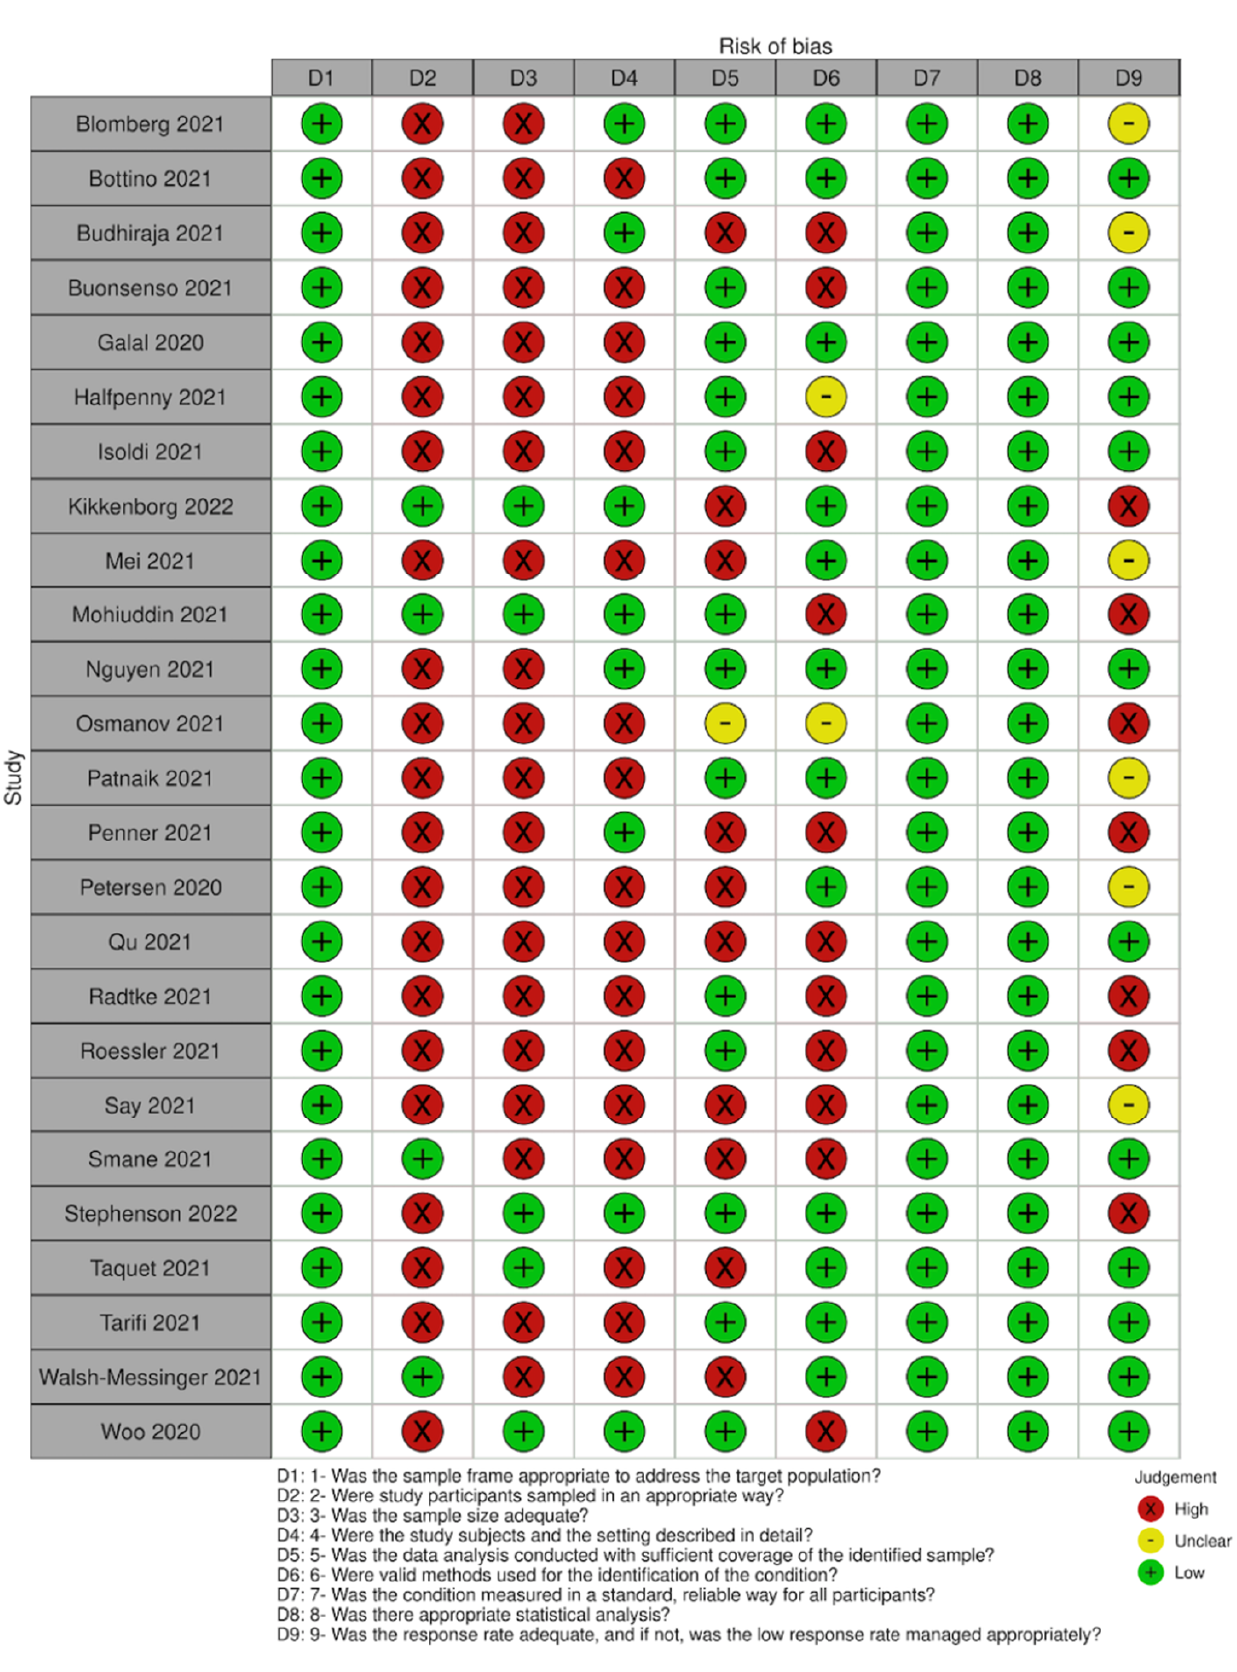
Figure 2. Summary of quality assessment .